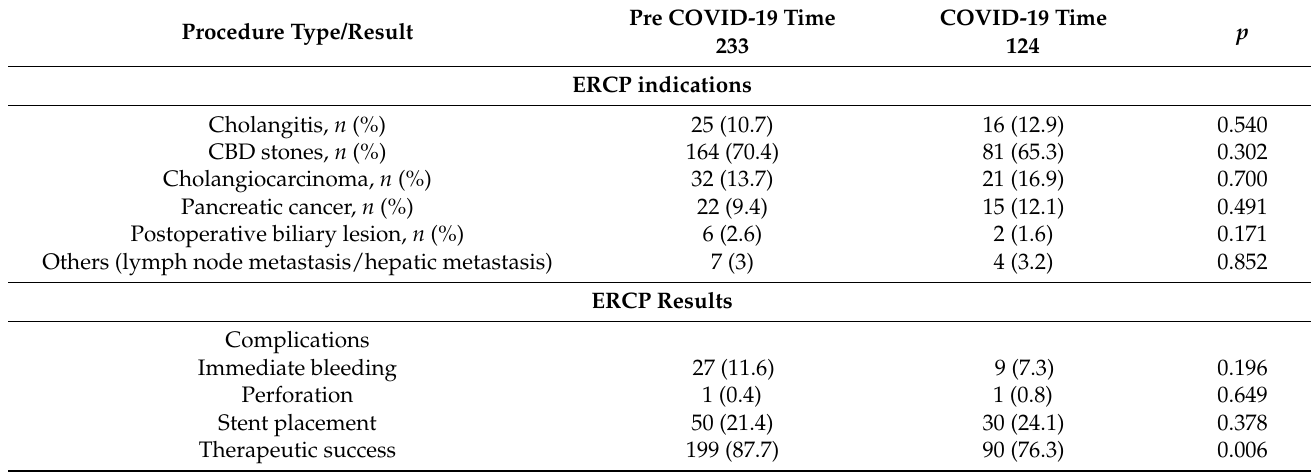
Table 3. Analysis of ERCP before and during the COVID-19